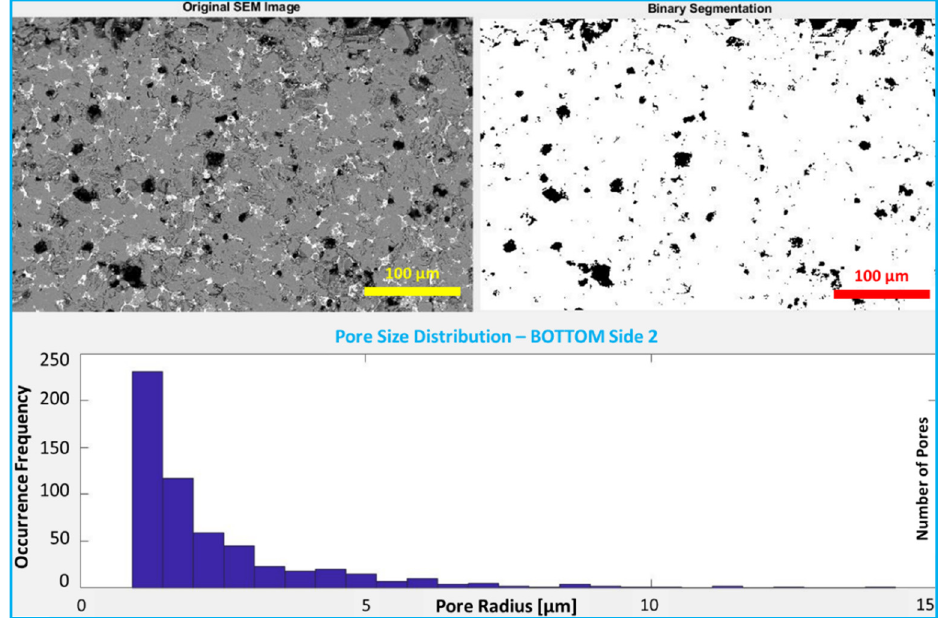
Figure 13. Porosity distribution analysis on the bottom, side 2, of the cross-section after AWJ cutting at v = 160 mm/min. at v = 160